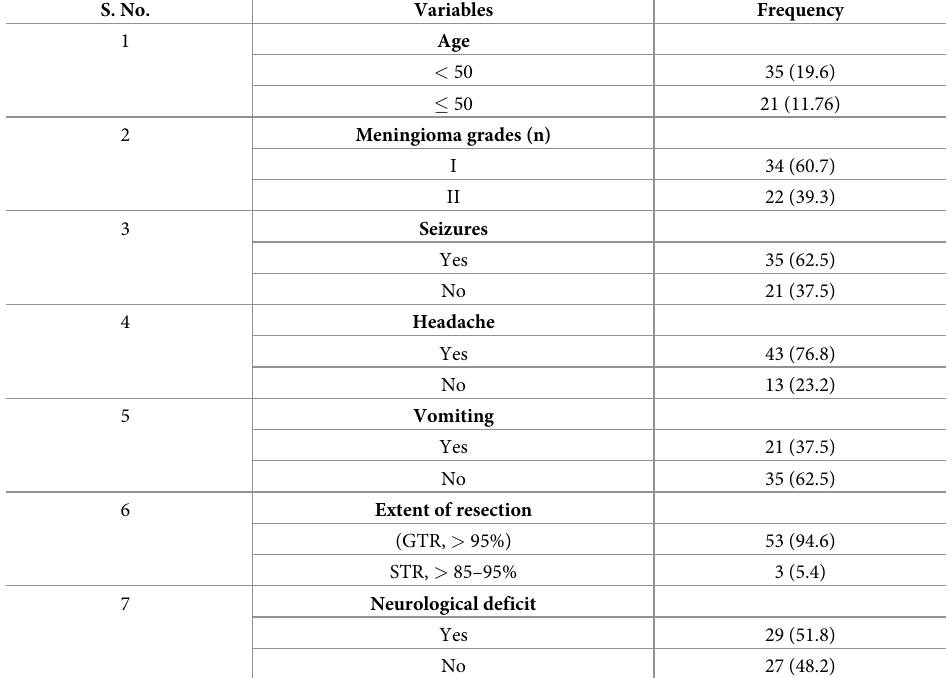
Table 1. Patients clinical characteristics (n =